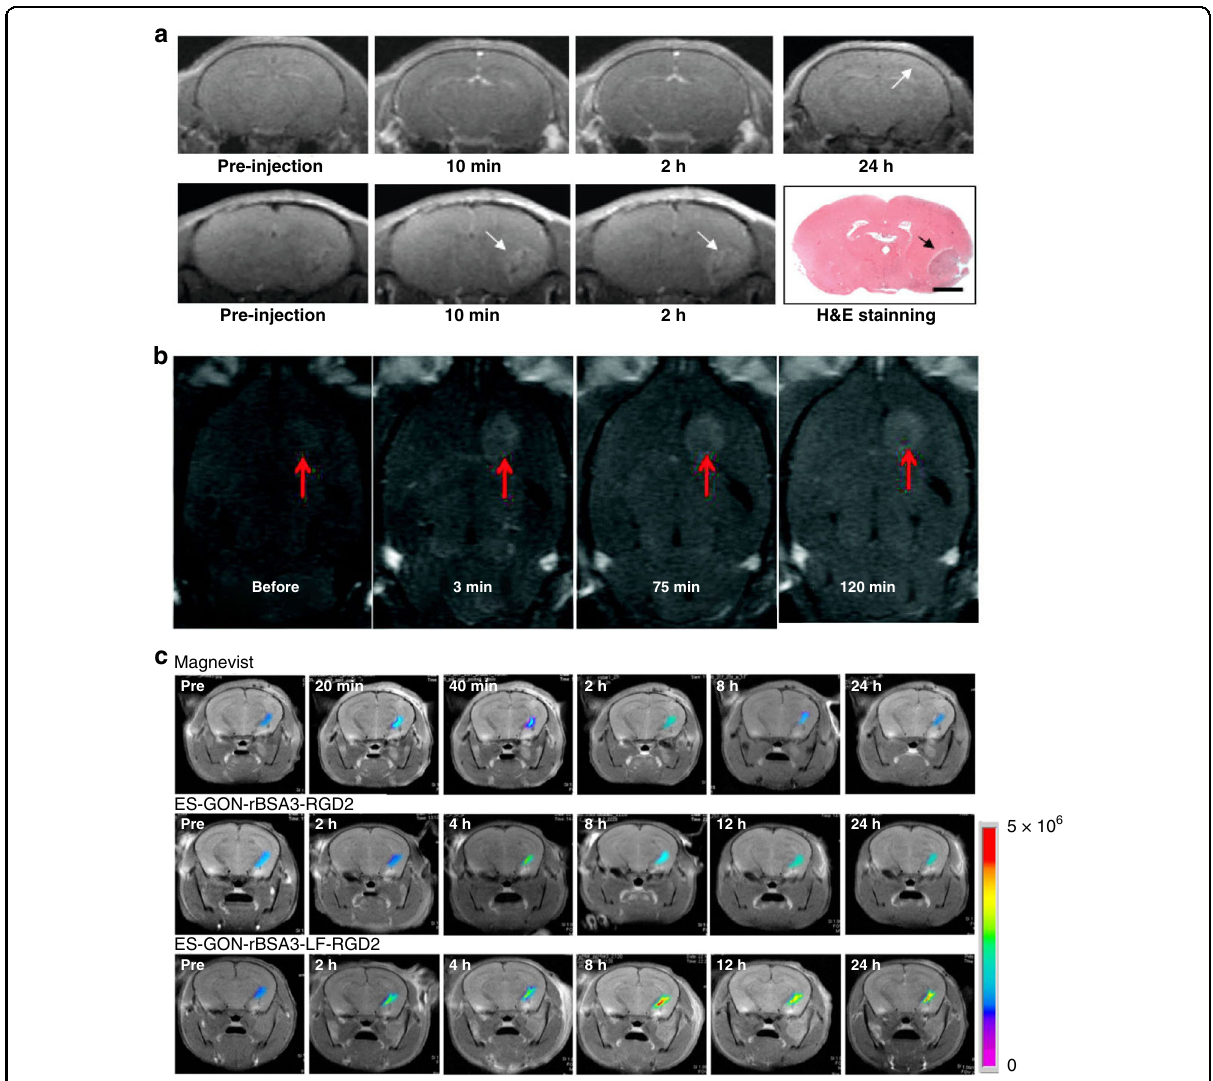
Fig. 2 In vivo brain MRI by using Gd-based CAs. a In vivo MRI of normal brain (top) and tumor-bearing brain (bottom) before and after injection of Den-RGD-Angio at different times. Reprinted with permission from ref. 41 . Copyright 2012 American Chemical Society. b In vivo MRI of rat brain tumor after injection of ultra-small Gd 2 O 3 nanoparticles. Reprinted with permission from ref. 45 . Copyright 2009 American Chemical Society. c In vivo MRI of tumor-bearing brain after injection of Magnevist, ES-GON-rBSA3-RGD2, and ESGON-rBSA3-LF-RGD2 at different times. Reprinted with permission